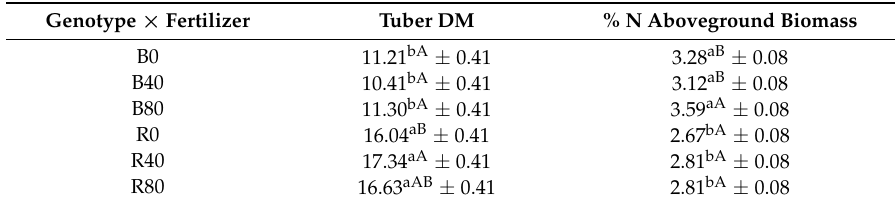
Table A5. Results of a multiple t-test at significance level of 5% after finding significant differences via global F-test for the factor genotype × fertilizer. Same lowercase letters indicate no significant differences between the genotypes and same fertilization level. Same capital letters indicate no significant differences between the fertilization levels within one